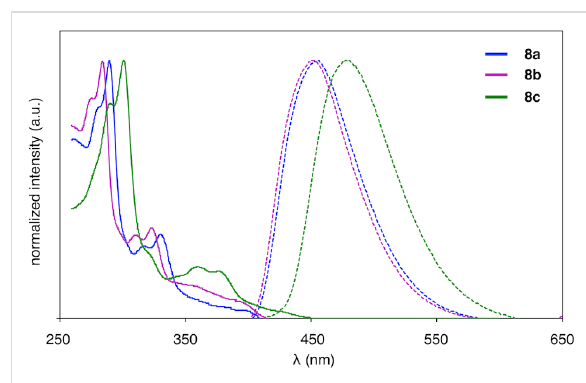
Figure 3: UV–vis absorption (solid lines) and fluorescence (dashed lines) spectra of compounds 8a – c .